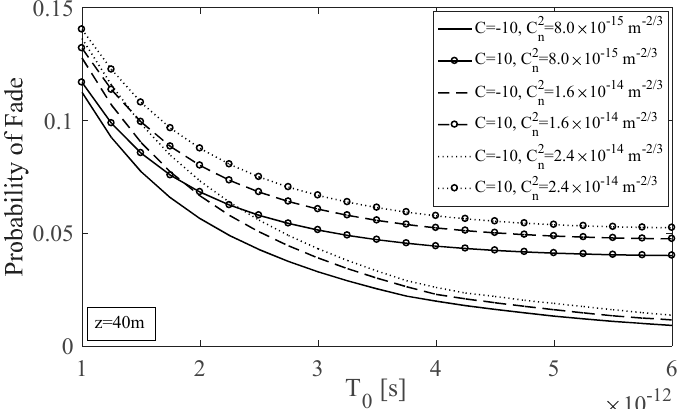
Figure 3. Probability of fade for a UOWC system under the joint action of GVD, time jitter and fluid turbulence effect, as a function of the longitudinal pulsewidth of the Gaussian pulse for a 40-m horizontal propagation distance and 100-m depth.